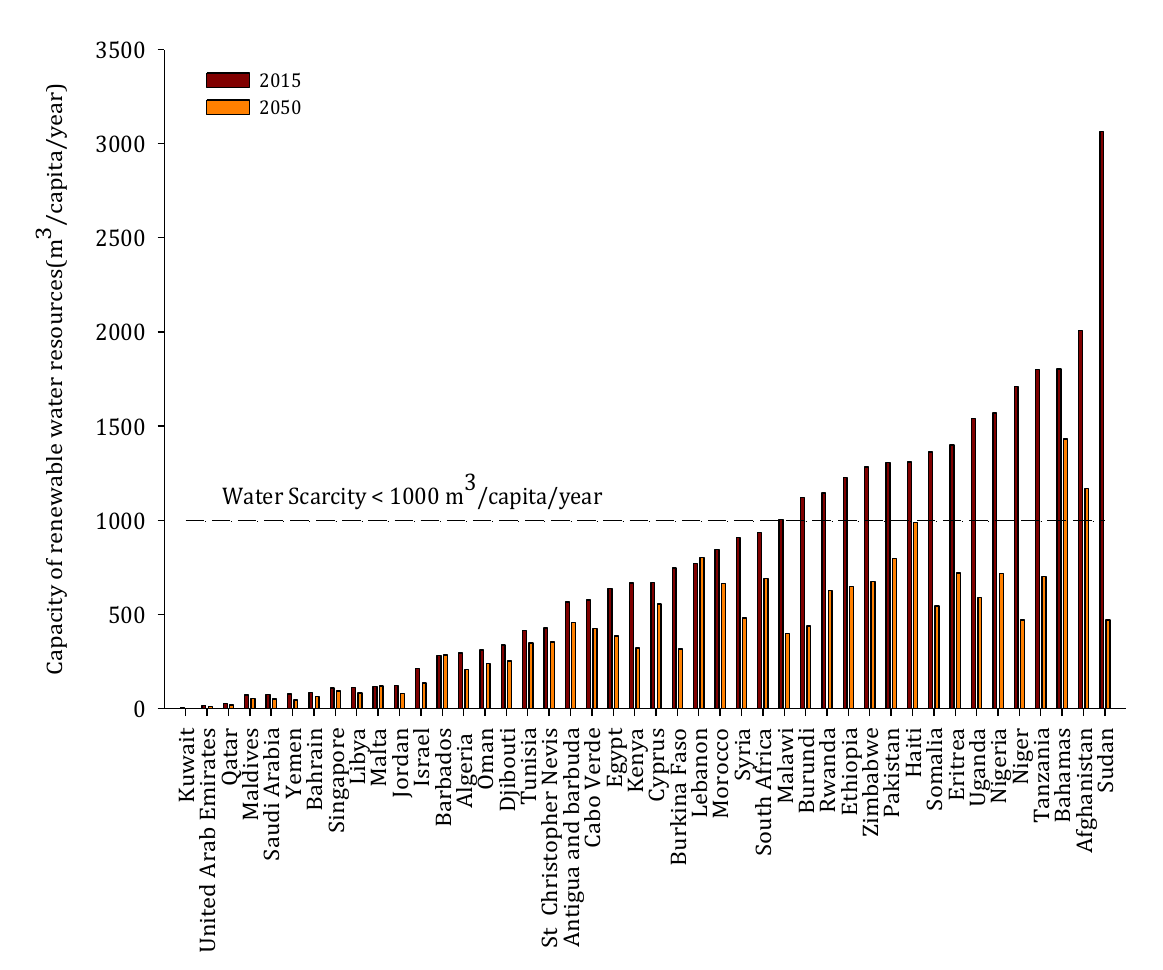
Figure 6. Countries expected to be water-scarce by 2050.